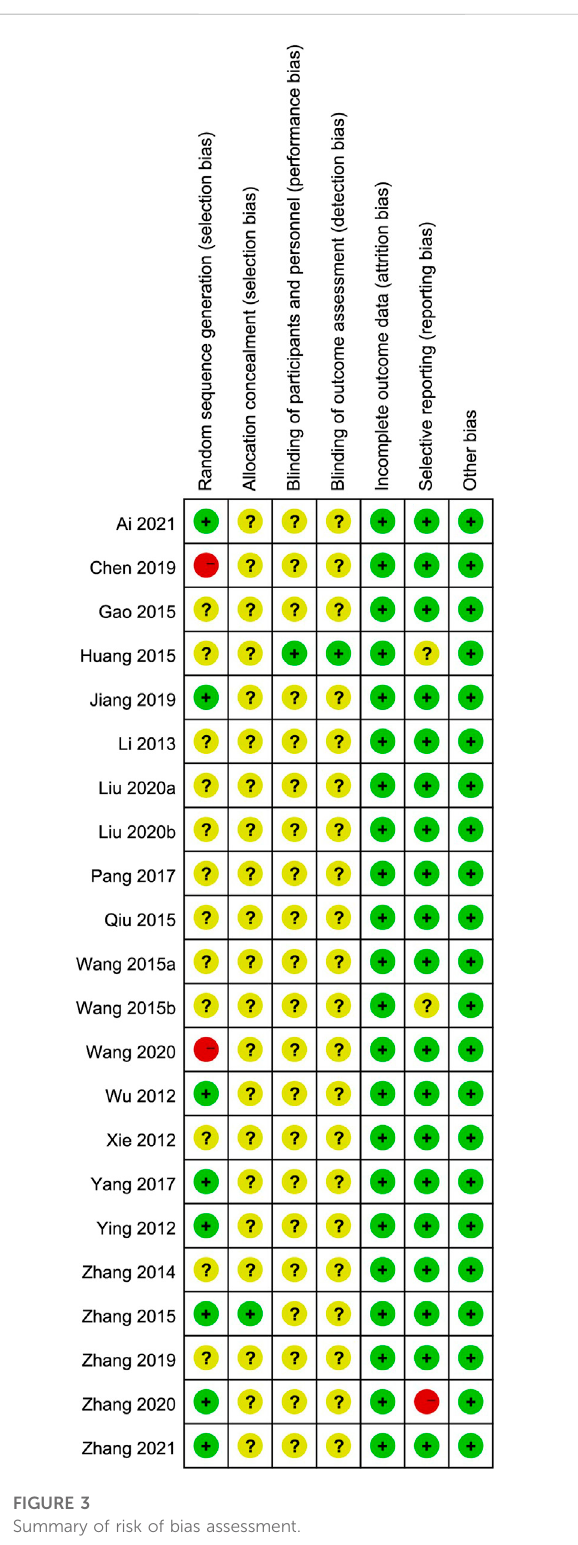
are depicted as mean difference (MD) or standardized mean difference (SMD), while categorical data are presented as risk ratios (RRs); all are expressed with a 95% con fi dence interval (CI). Furthermore, the χ 2 and I 2 tests were used for heterogeneity analysis.